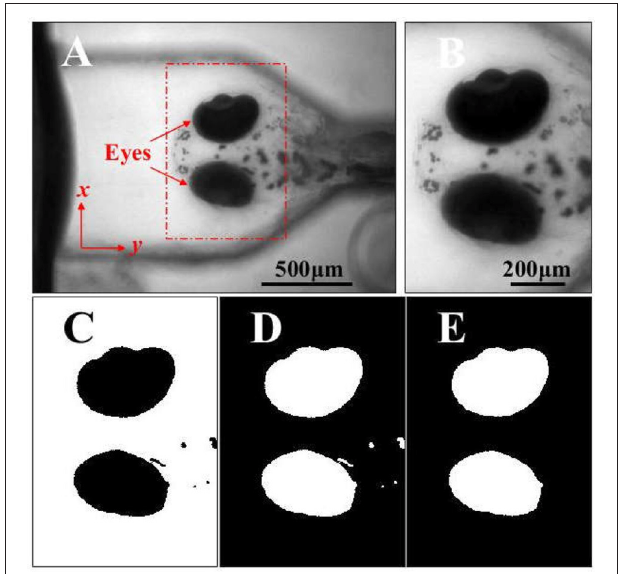
FIGURE 2 | (A) The head and eyes (red arrows) of a zebrafish larva acquired in a video series by the VOR test system. (B) The ROI containing the eyes is selected and used to analyze the eye movements and VOR. (C) The binary image of image in B (black eyes). (D) The inversed binary image of image in C (white eyes). (E) The inversed binary image in D , where the small flecks are removed by applying the area threshold, and the image is subsequently